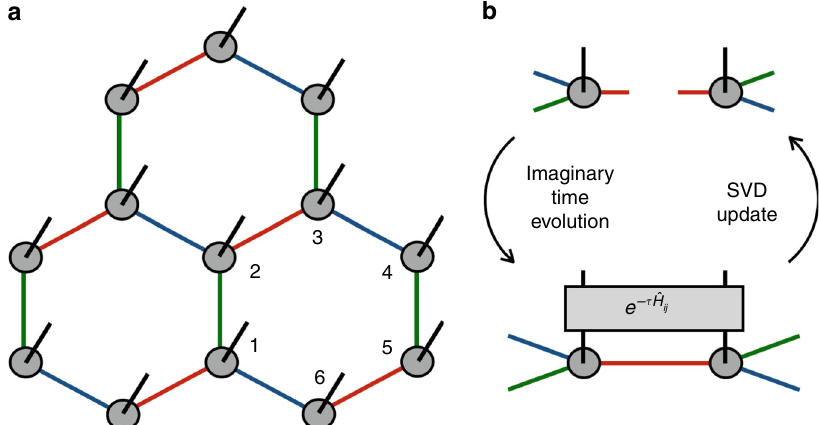
Fig. 5 Methods. Schematic fi gures of a the honeycomb TPS where the x -, y - and z -bonds de fi ned in Eq. (1) are speci fi ed by red, blue and green colors, respectively, and b the optimization and update processes of the local tensor, where the black solid line denotes the physical degrees of freedom and e (cid:3) τ ^ H ij is the local imaginary time evolution operator (see text for